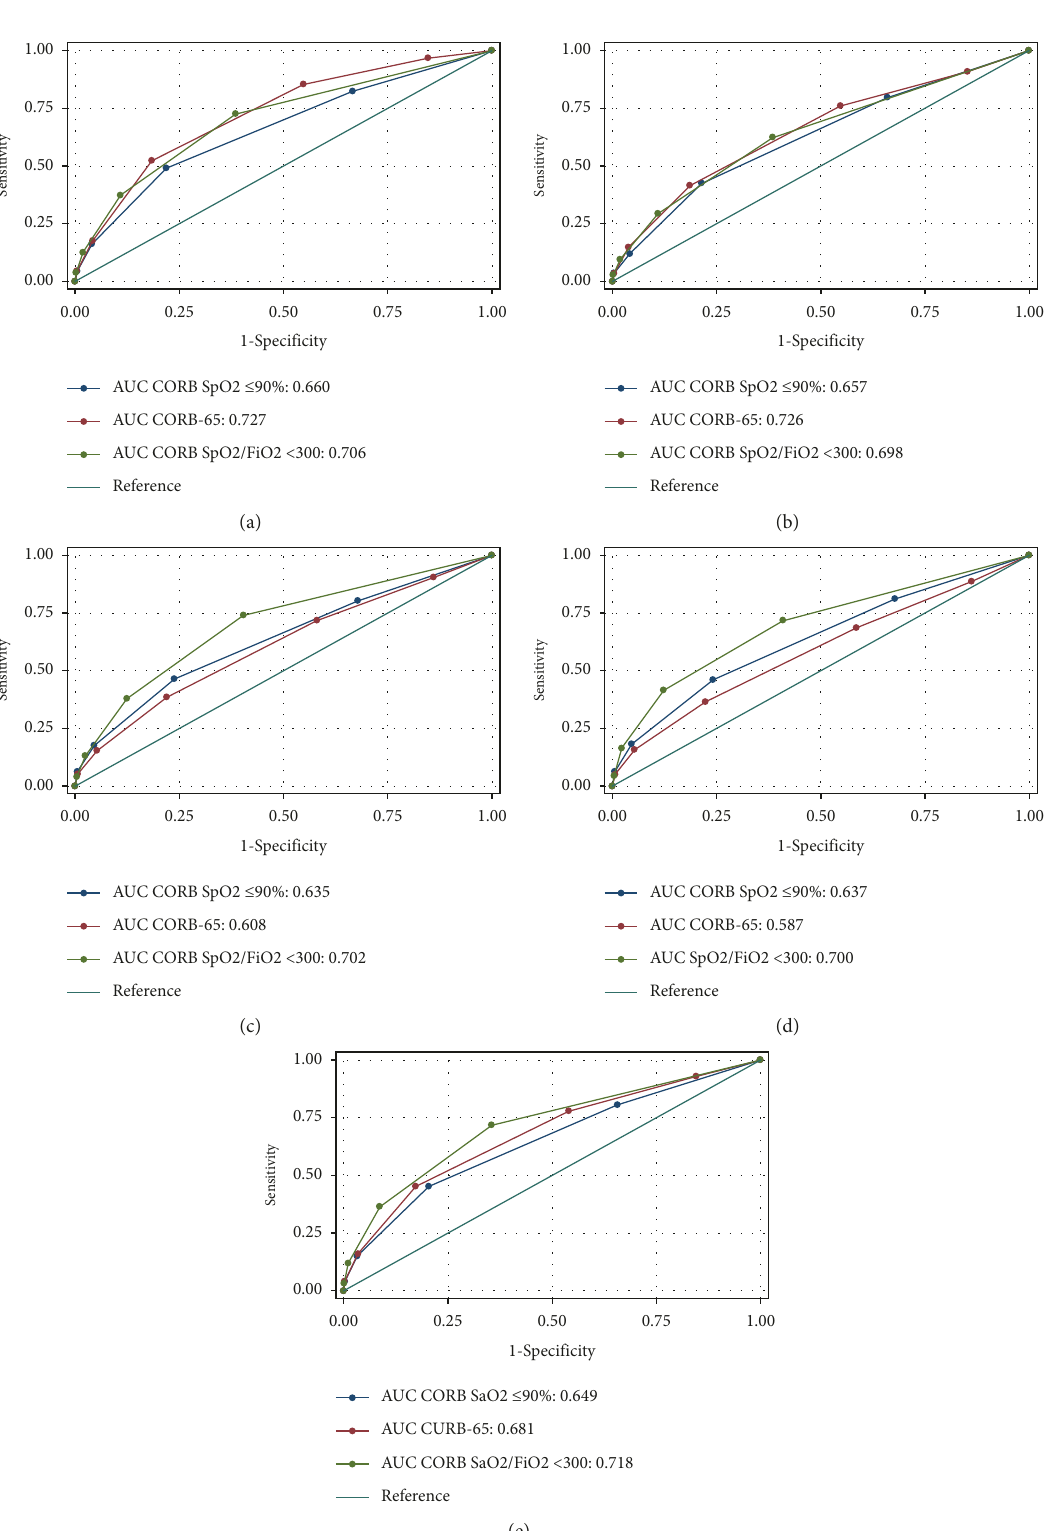
Figure 2: Comparison of performance between CORB score, CORB score with SpO 2 /FiO 2 and CURB-65 (values correspond to the area under the receiver operating characteristic curve-AUC) estimated in Table 3. (a) In-hospital mortality. (b) 30-day mortality. (c) Vasopressor requirement. (d) Mechanical ventilation requirement. (e) Composite outcome (in-hospital mortality/IMV requirement/vasopressor